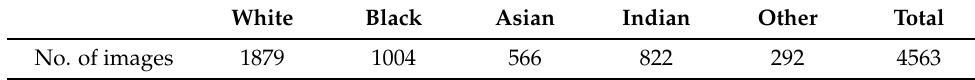
Table 8. Distribution of images by ethnicity in the UTKFace filtered testing set. White Black Asian